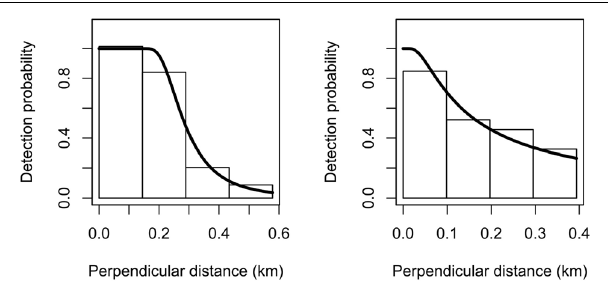
FIGURE 2 | Fitted hazard-rate detection functions (solid lines) for Commerson’s dolphins (left) and Peale’s dolphins (right) . The detection function is superimposed on a histogram of detection probabilities with bars scaled so that their areas match the area below the detection